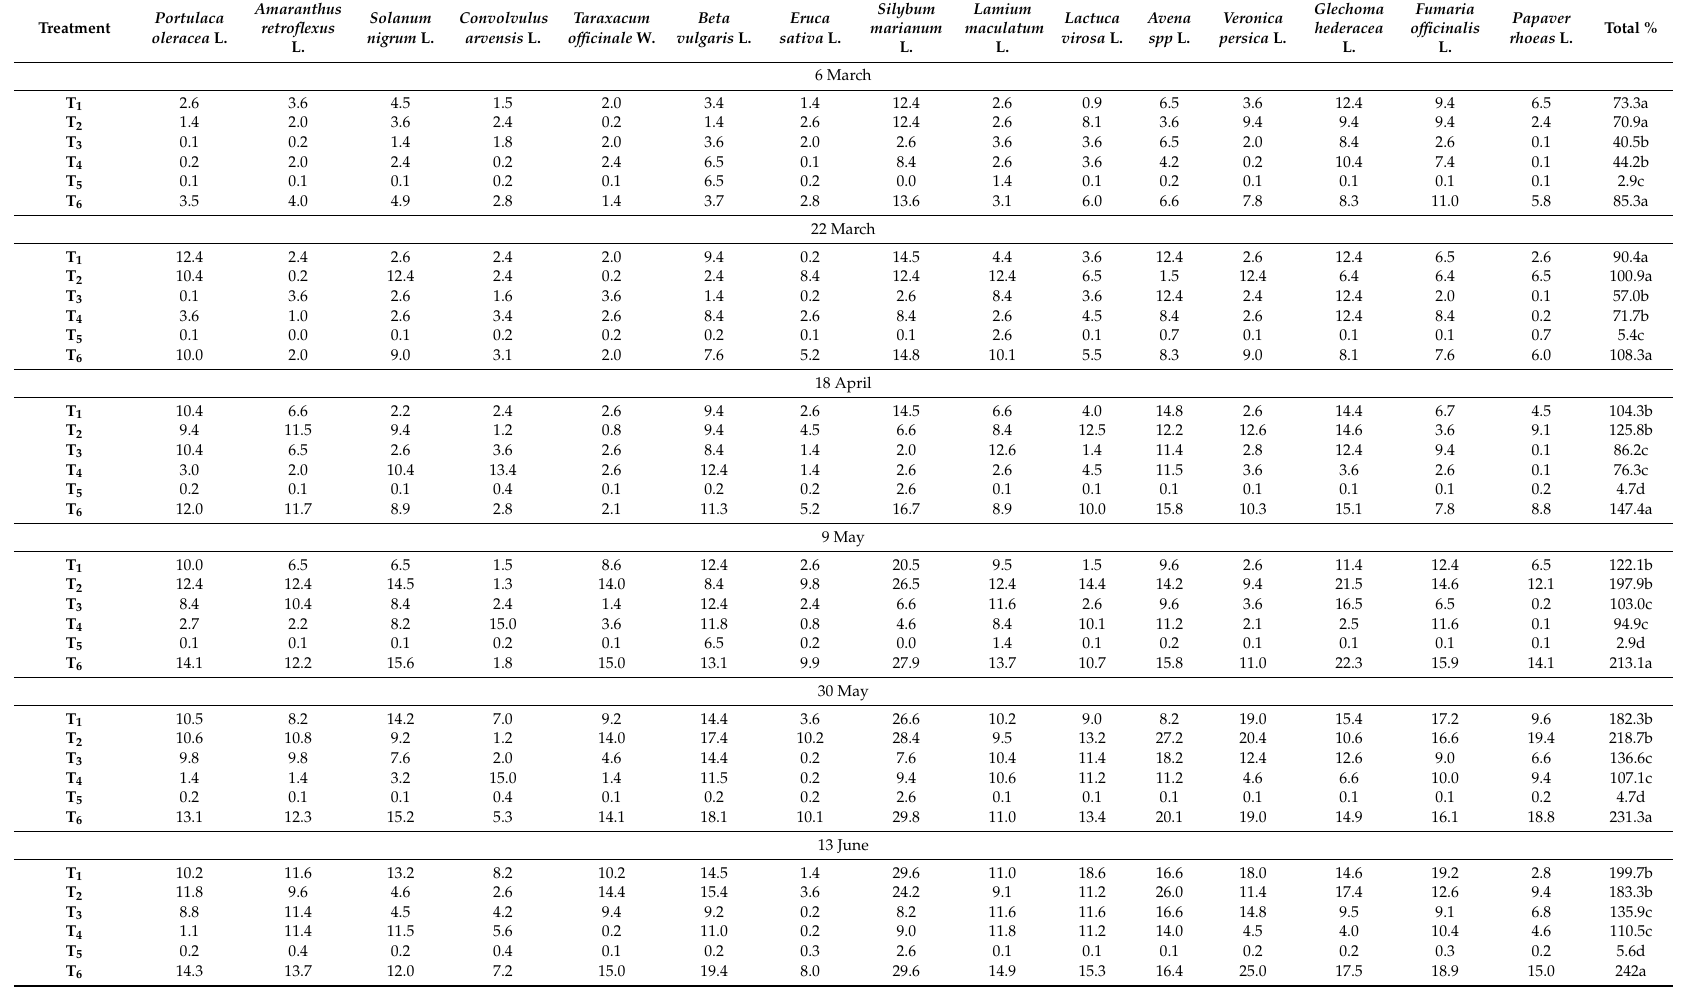
Table 3. E ff ect of treatments on weed ground cover percentage (WGC %) at di ff erent surveys during the 2012–2013 season.